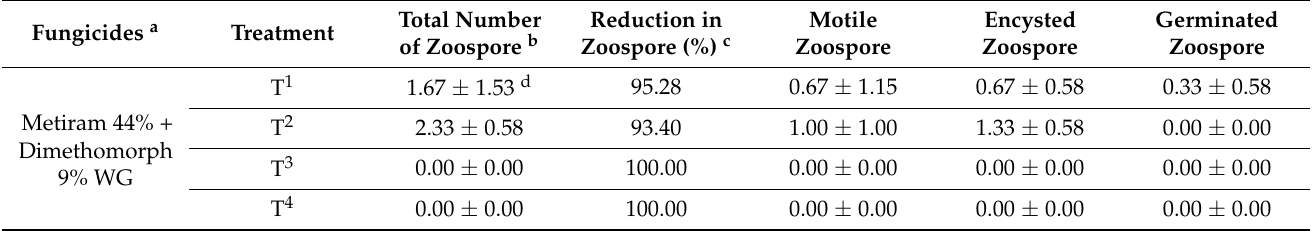
Table 3. Effect of fungicides and time of fungicide application on P. cajani zoospore